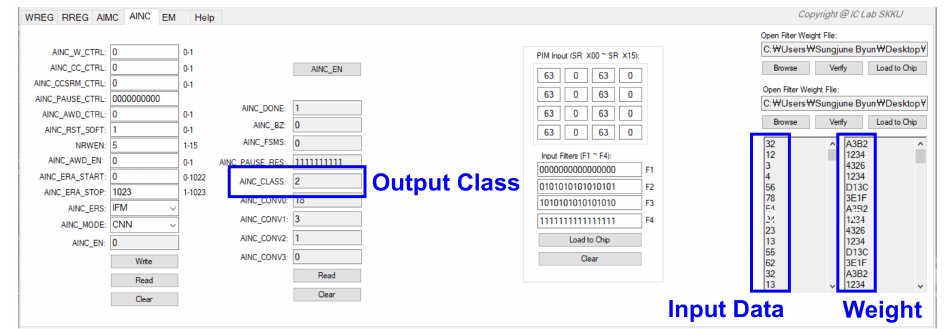
Figure 20. Measurement result of CNN